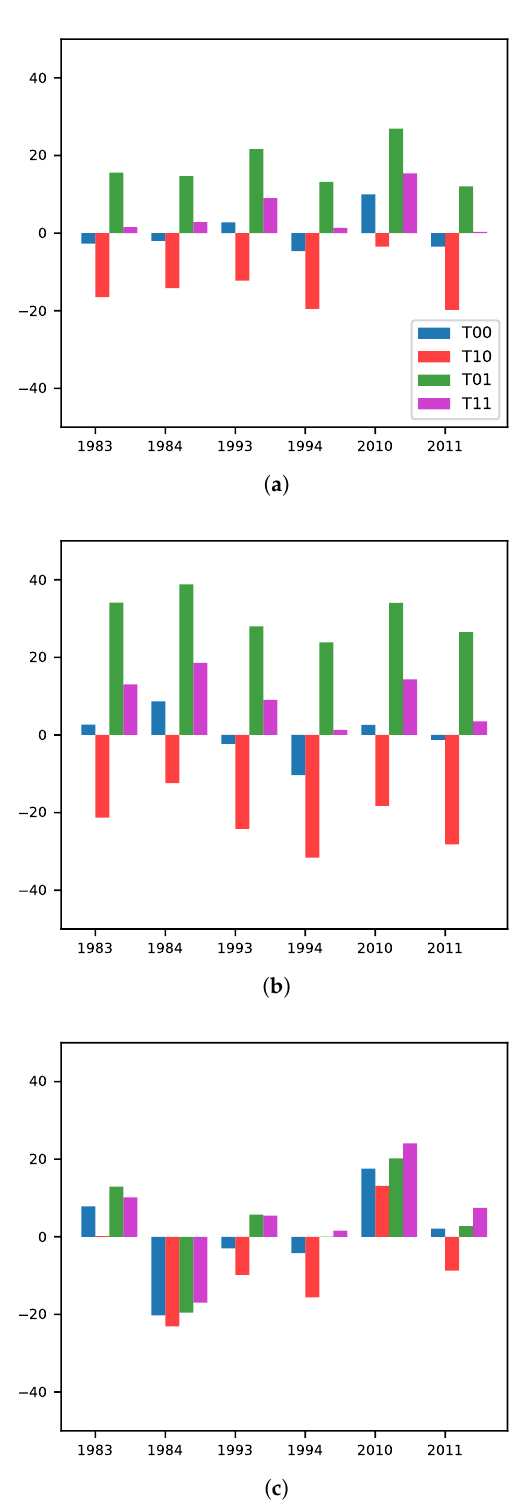
Figure 6. ( a ) WA, ( b ) Guinea and ( c ) Sahel interannual variability of the JAS rainfall anomalies relative to the control simulation study period